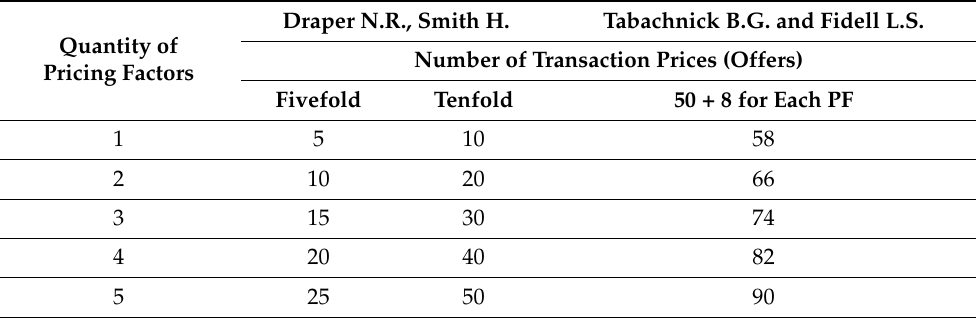
Table 2. Required ratio of the number of pricing factors and units of market information. Quantity